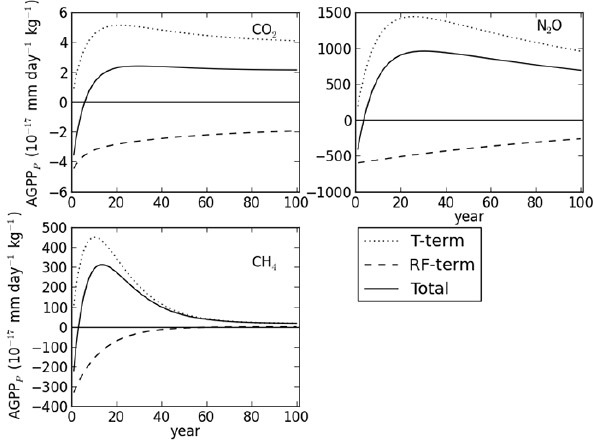
Figure 1. AGPP P for 1kg pulse emissions of CO 2 , N 2 O and CH 4 . The T term and RF term refer to the first and second terms on the right hand side of Eq. (3) respectively, and the Total is the sum of